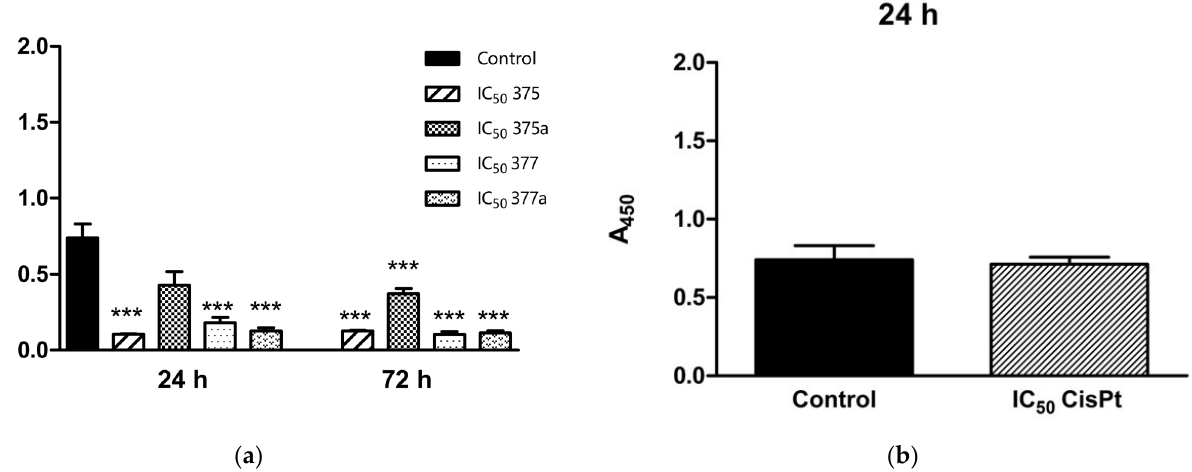
Figure 2. Changes in proliferation status of HEC-1A endometrial cancer cells after 24- and 72-h incubation with 375 (rhenium aspirin), 375a (aspirin), 377 (rhenium indomethacin) and 377a (indomethacin) at IC 50 concentrations ( a ). The assay was performed using the BrdU proliferation kit (Biovision). Cisplatin (CisPt) was used as a positive control ( b ). Data were obtained by measuring absorbance at 450 nm in three independent experiments. Results were statistically compared with the negative control (untreated cells with 1% DMSO dissolved in cell culture medium) using a Two-way ANOVA with Bonferroni multiple comparison test; *** = p < 0.001. Table 4. Effect of 375 , 375a , 377 , and 377a at IC 50 , ½ IC 50 , and ¼ IC 50 concentrations on HEC-1A cells proliferation. Results are presented for 24- and 72-h incubation periods. One-way ANOVA with Bonferroni’s comparison test was chosen for statistical analysis.